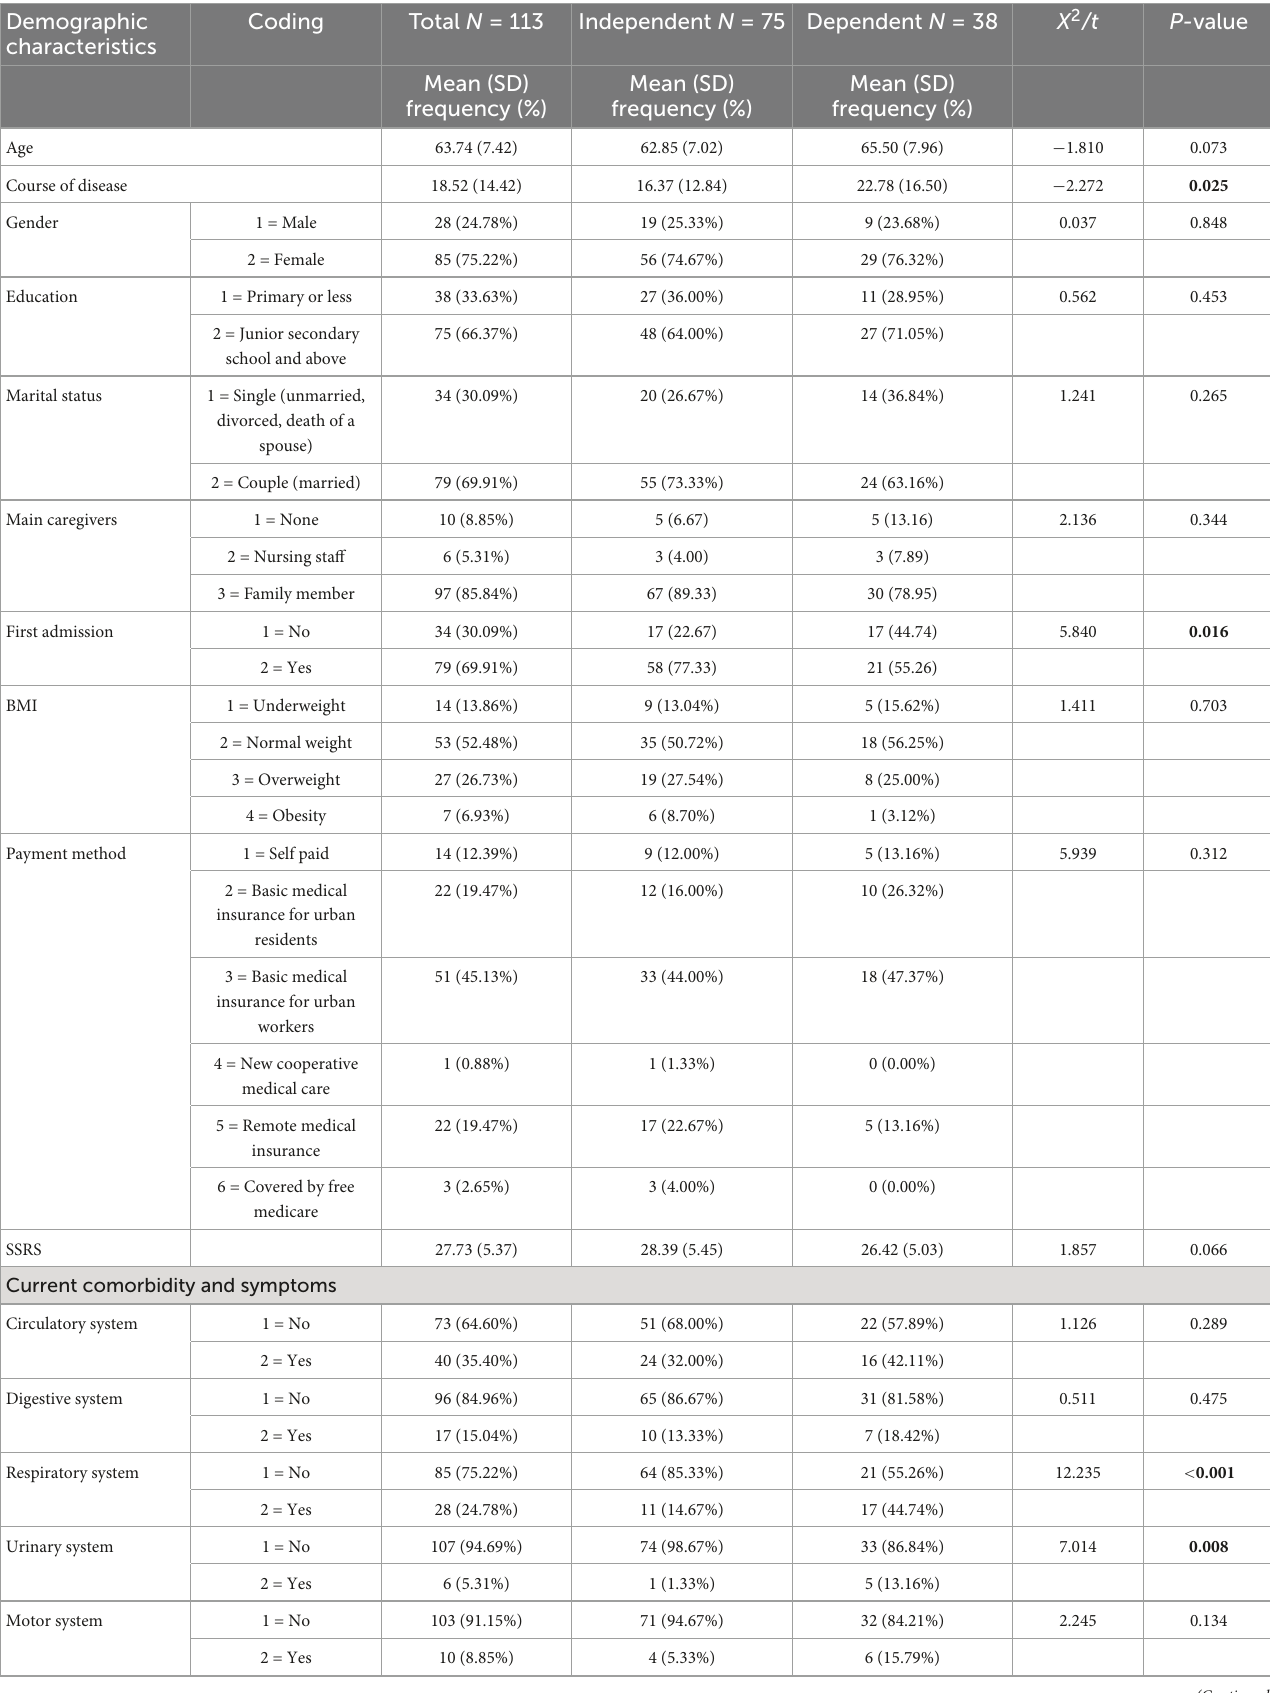
TABLE 1 Comparison of demographic and clinical data between patients with dependent function capacity and independent function capacity. Demographic